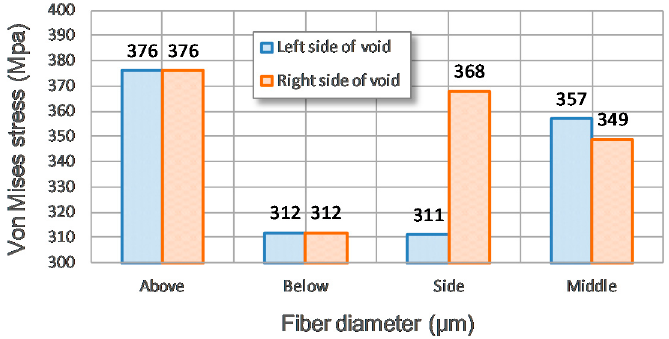
Figure 23. Stress magnitude on the both sides of the void for the four stress fields with different positions of hole defects relative to the reinforcing SiC fibers.